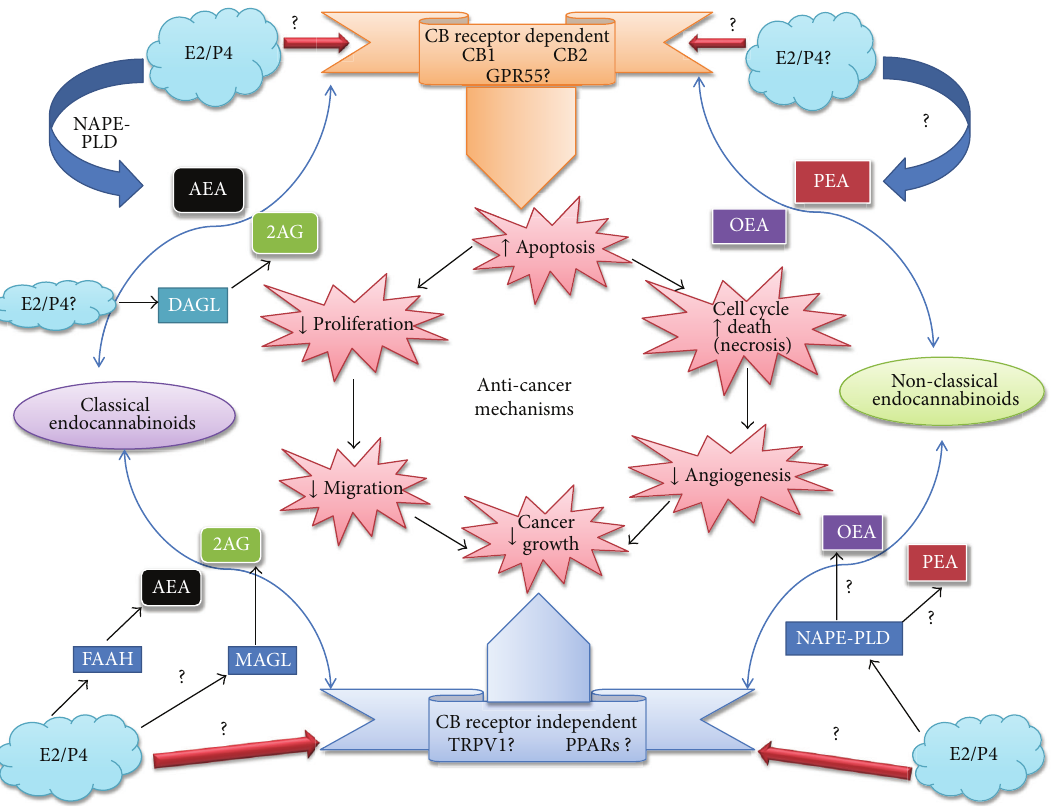
Figure 5: Known and putative interactions between gonadal sex steroids and the endocannabinoid system in sex hormone-dependent cancers. Endocannabinoid synthesis occurs through the actions of specific enzymes (blue boxes and broad arrows) through enzymatic hydrolysis of membrane specific NArPE lipid precursors. The role of the sex steroid hormones oestradiol (E2) and progesterone (P4) (blue clouds) is only speculative. The classical (anandamide (AEA) and 2-arachidonoylglycerol (2-AG)) and nonclassical endocannabinoids ( N - oleoylethanolamine (OEA) and N -palmitoylethanolamine (PEA)) independently or collectively bind at both classical (CB1, CB2, and GPR55) and nonclassical (TRPV1 and PPAR) receptors (ribbons) to affect anticancer mechanisms (pink starbursts in the centre of the figure), which may be linked (arrows) or may not be linked to each other, but all result in reduced cancer cell mass. Known interactions between sex steroid hormones and the endocannabinoid system in the anticancer mechanisms are shown, whereas speculative or unknown interactions are indicated by the presence of a question mark. Up and down arrows indicate either an increase or decrease in the activity of that particular anticancer